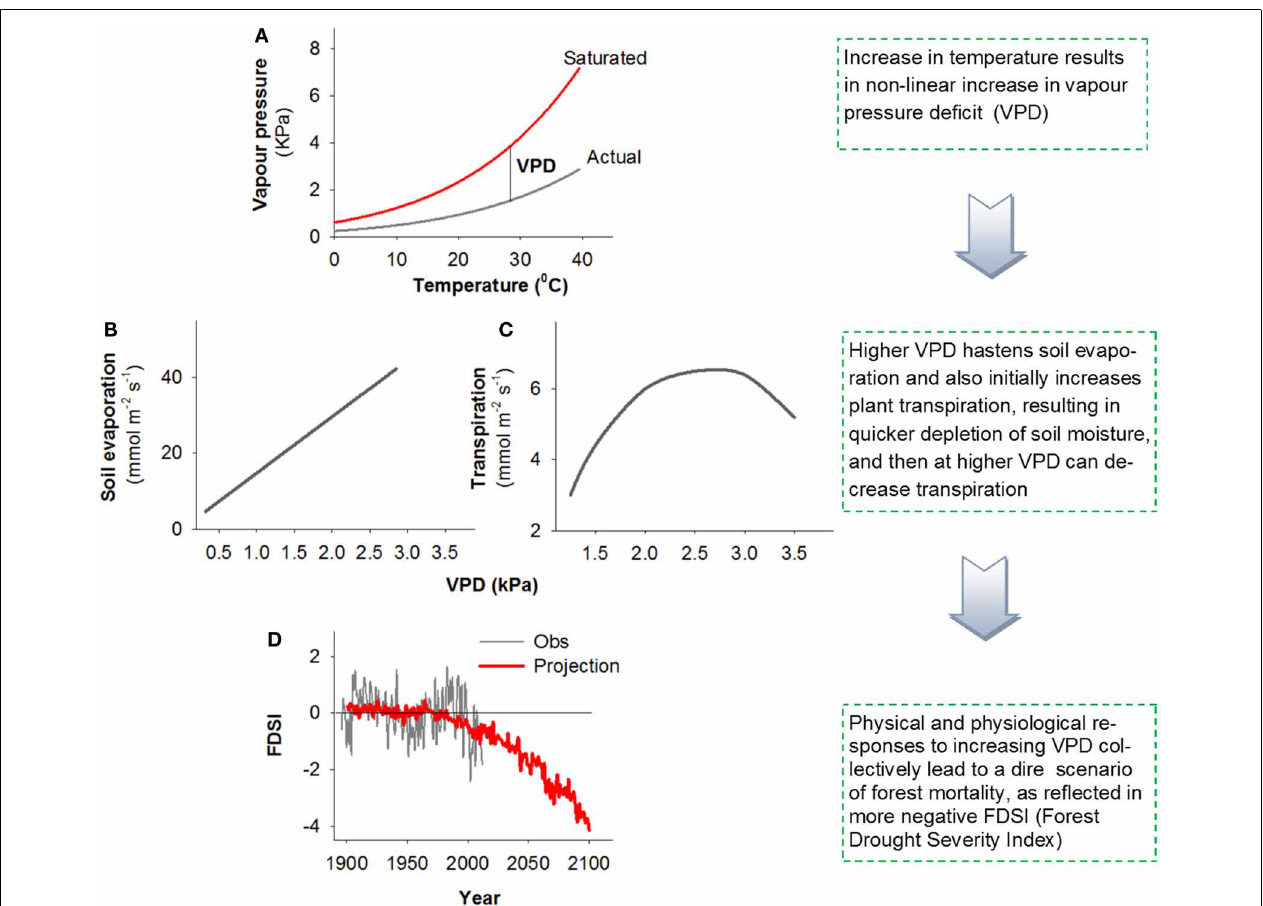
FIGURE 1 | A conceptual figure illustrating the effect of increased VPD on the biophysical factors that influence tree physiology, drought stress, and survival. Higher temperatures increase VPD non-linearly (A) , higher VPD will generally both deplete soil moisture (B) and increase plant stress though changes in transpiration [ C ; based on